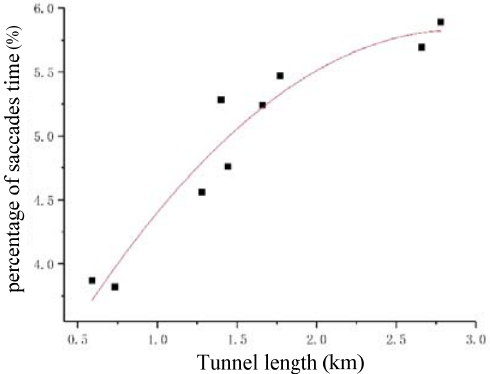
Figure 9. The fitted curve of tunnel length and percentage of scanning time.